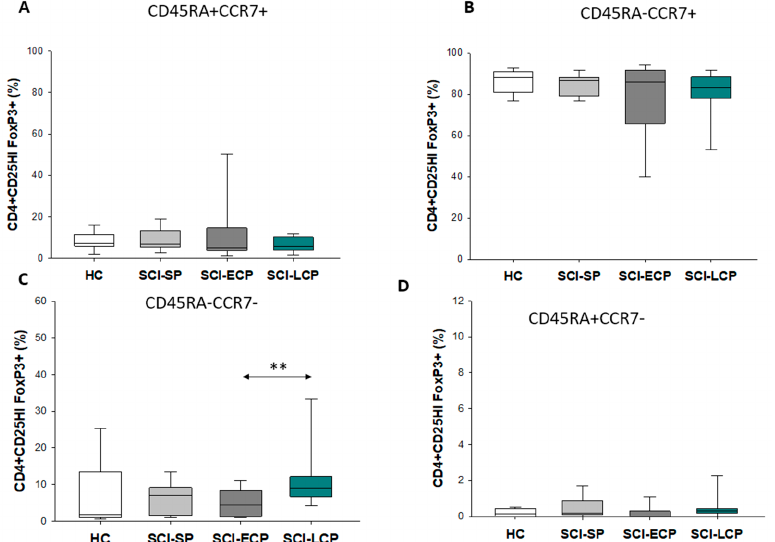
Figure 3. CD45RA and CCR7 expression in CD4+ CD25hi Foxp3+. 4 subpopulations are recognized: ( A ) CD45RA+ CCR7+; ( B ) CD45RA − CCR7+; ( C ) CD45RA − CCR7 − ; ( D ) CD45RA+ CCR7 − . Healthy controls (HCs); chronic SCI patients with a short period of evolution (1–5 years (SCI-SP)); chronic SCI patients in the early chronic phase (5–15 years (SCI-ECP)); and chronic SCI patients in the late chronic phase (>15 years-(SCI-LCP)). p < 0.01 (**).